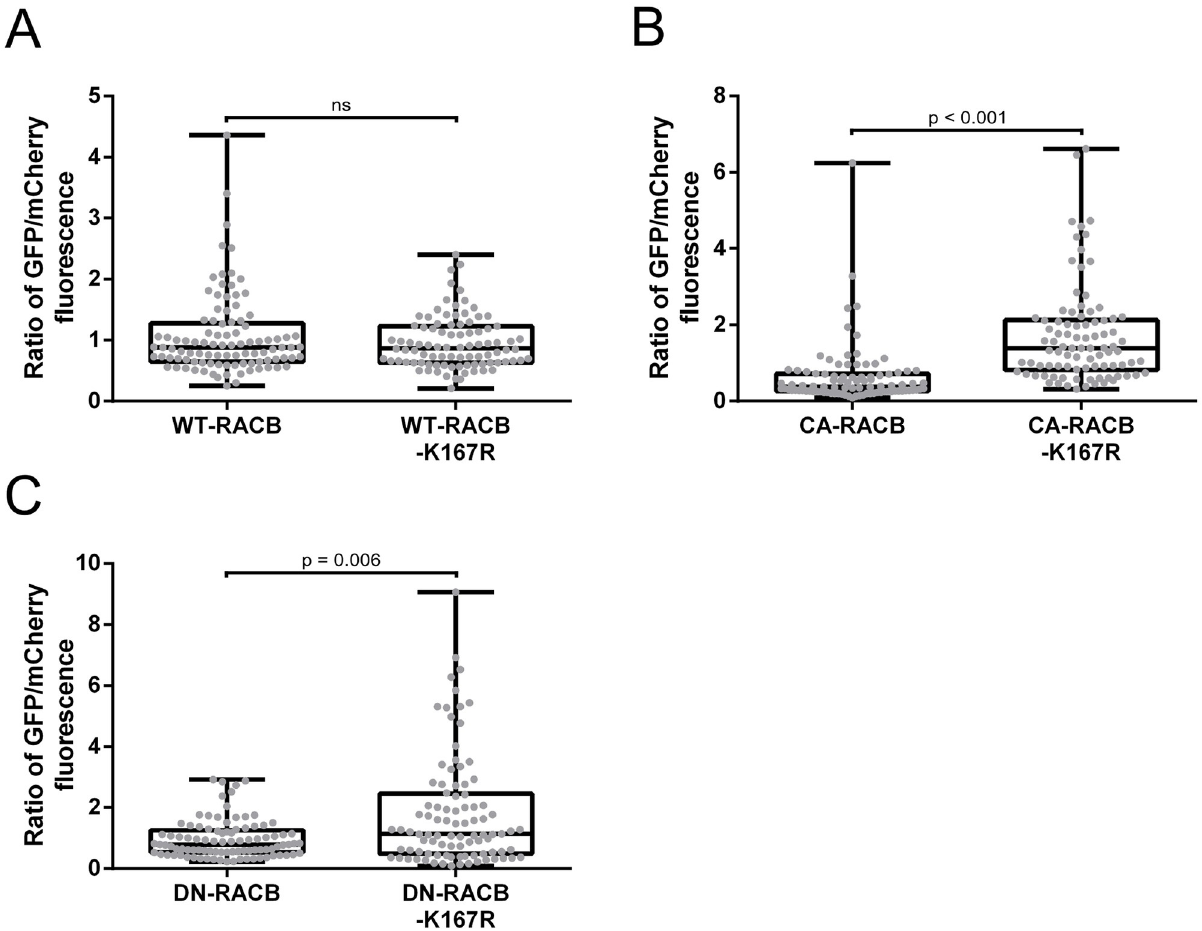
Fig 6. Quantification of GFP-RACB(-K167R) fluorescence intensities. GFP-tagged RACB-variants (WT (A) , CA (B) and DN (C) ) and their corresponding non-ubiquitinatable K167R mutants were transiently expressed in single barley epidermal cells via particle bombardment. Free mCherry was co-expressed in all experiments as a normalizer. Mean pixel fluorescence intensities for GFP and mCherry were measured using a confocal laser- scanning microscope. For comparison, ratios of fluorescence were calculated by dividing the measured fluorescence signal of GFP-RACB by that of free mCherry in each individual cell. In case of GFP-CA- and GFP-DN-RACB, the K167R mutants displayed higher fluorescence levels than their non- mutated K167 counterparts, whereas GFP-WT-RACB(-K167R) fluorescence levels were similar. Each datapoint represents one transformed cell. All datapoints were collected over three biological replicates. Laser excitation levels were different for all three RACB activity variants, but kept identical for regular and K167R RACB forms. Statistical analysis was performed with Wilcoxon rank-sum tests with continuity correction against a p-value of 0.05.